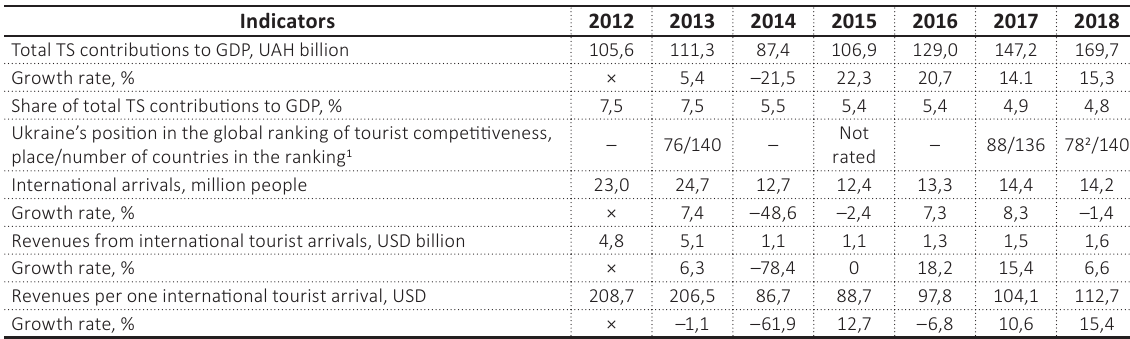
Table 2. Dynamics of the main indicators of the Ukrainian tourism sector (TS) development for